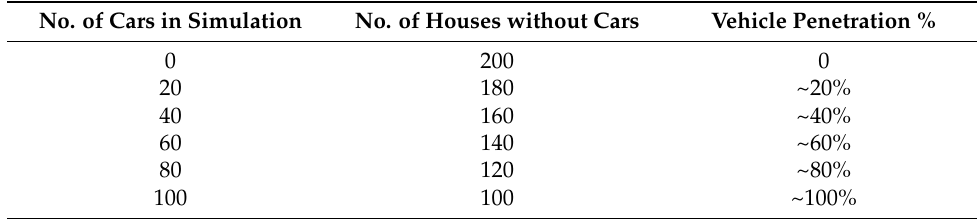
Table 1. EV penetration scenarios for network 1 [19].